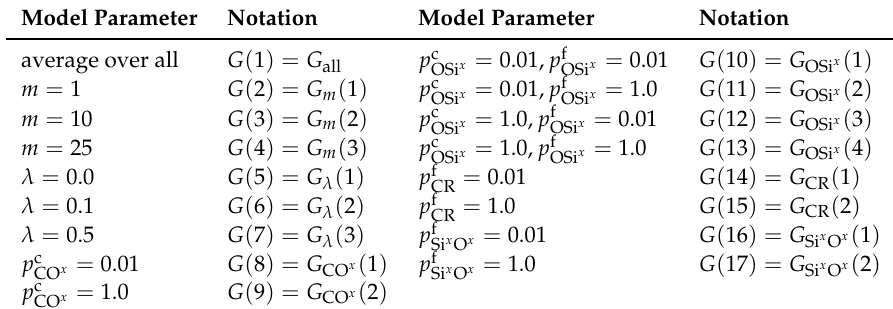
Table 3. 17 parameter groups G ( i ) are defined, where typically one parameter value is fixed. The corresponding parameter values for each group are given in first column and the short notation in the